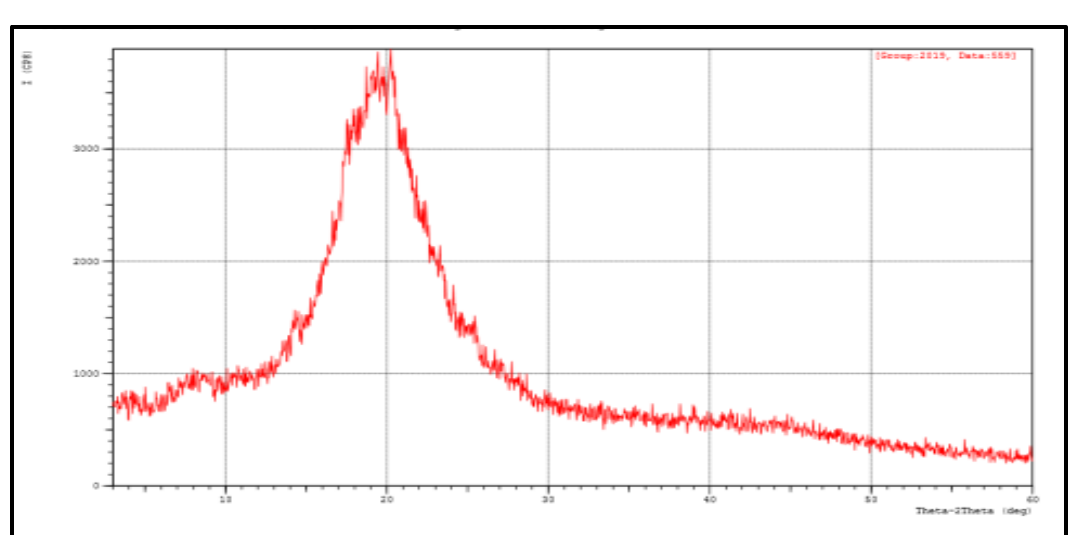
Figure 16.XRD of ITZ selected formula (F16)